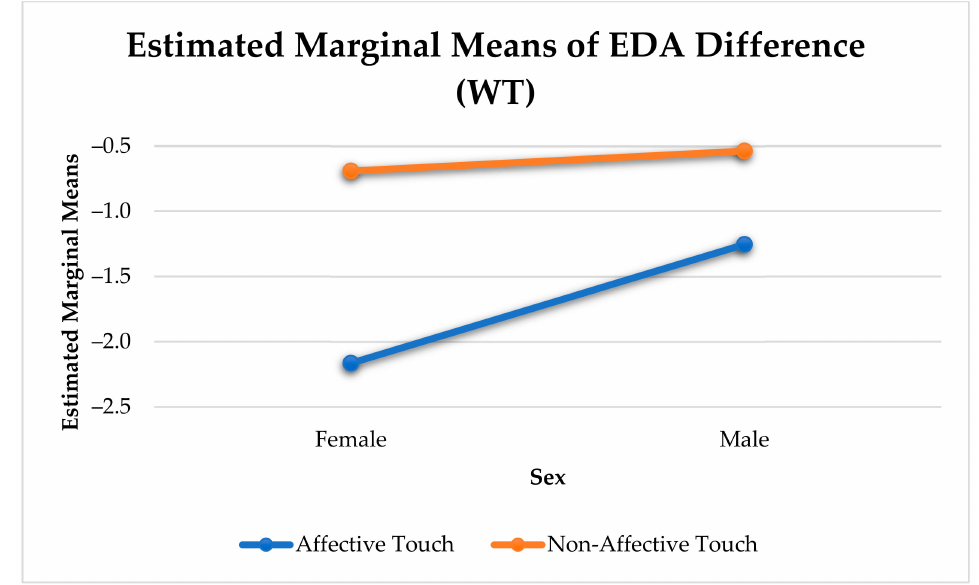
Figure 8. Sex Differences in Physiological Arousal Change Elicited by Affective and Non-affective Touch.